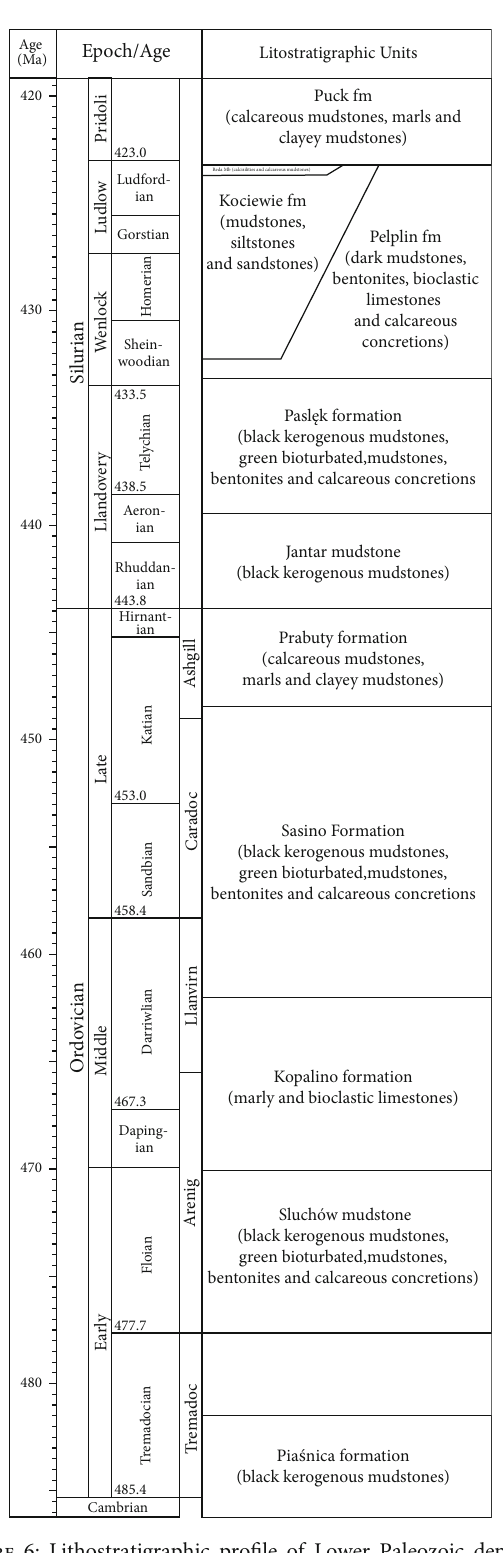
Figure 6: Lithostratigraphic pro fi le of Lower Paleozoic deposits; Pas łę k Formation: Pas łę k fm; Prabuty mudstone: O3; Kopalino formation: OrV; after Por ę bski and Podhala ń ska